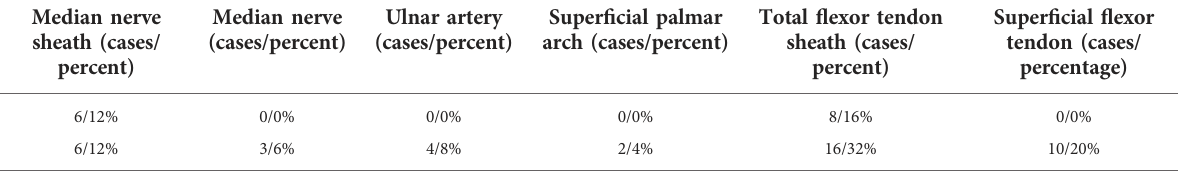
TABLE 3 Number and percentage of injuries in the two groups.